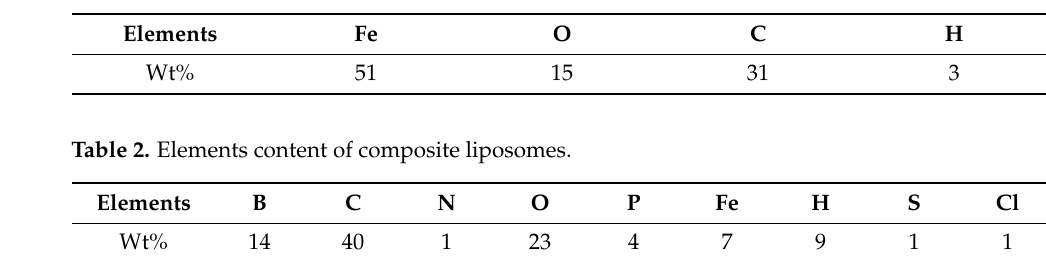
Table 1. Elements content of Fe 3 O 4 @OA NPs.